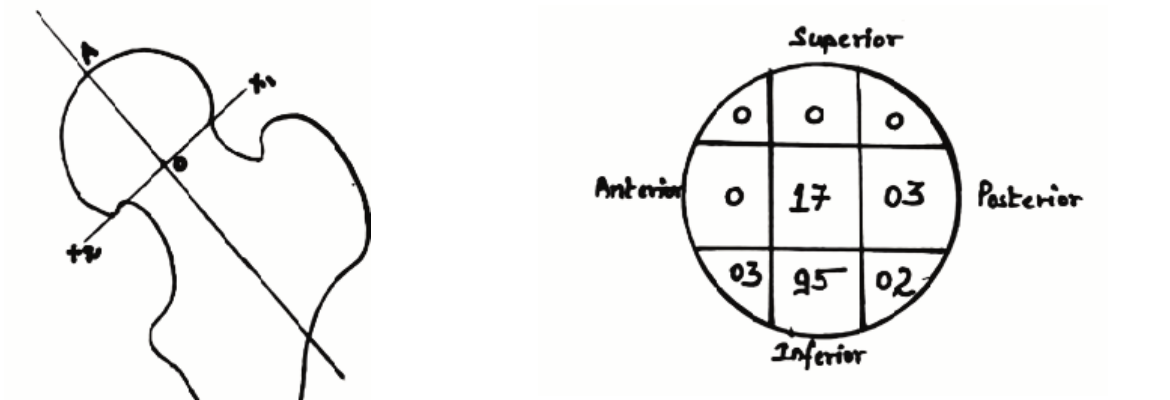
Defining the apex of femur head. Fig. 2: